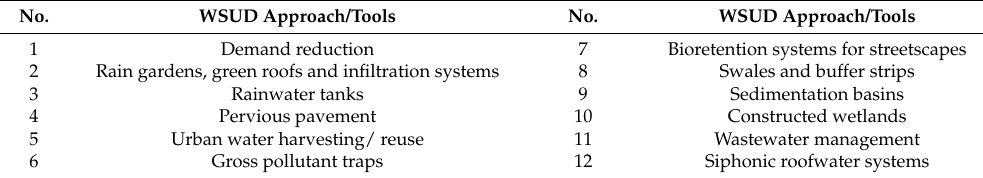
Table 1. The Water Sensitive Urban Design (WSUD) tools for adoption